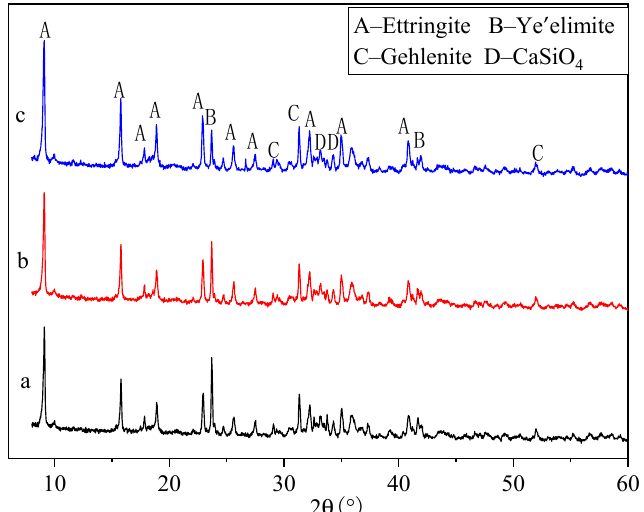
Figure 5. XRD patterns of hydrated binder materials ( a –hydration 1 d, b –hydration 3 d, c –hydration 28 d).